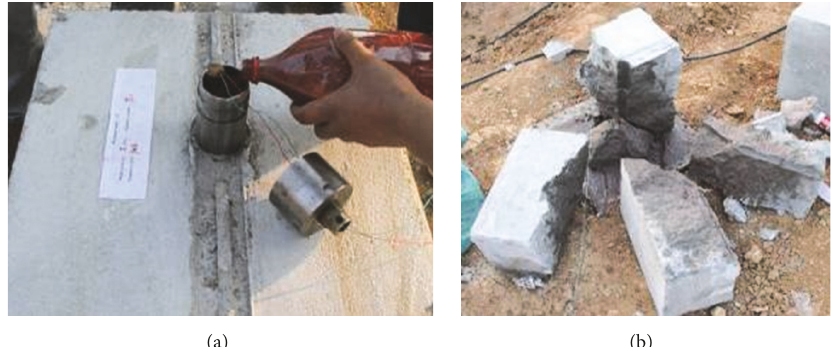
Figure 9: The states of the cement block in the A2B1C2 case: (a) before and (b) after being blasted.